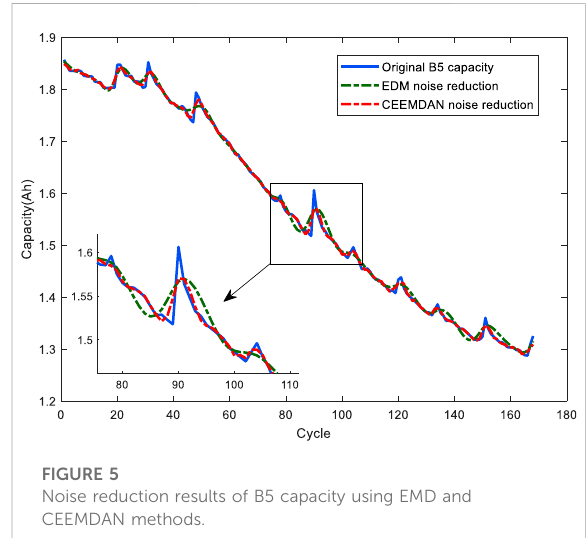
FIGURE 5 Noise reduction results of B5 capacity using EMD and CEEMDAN methods.